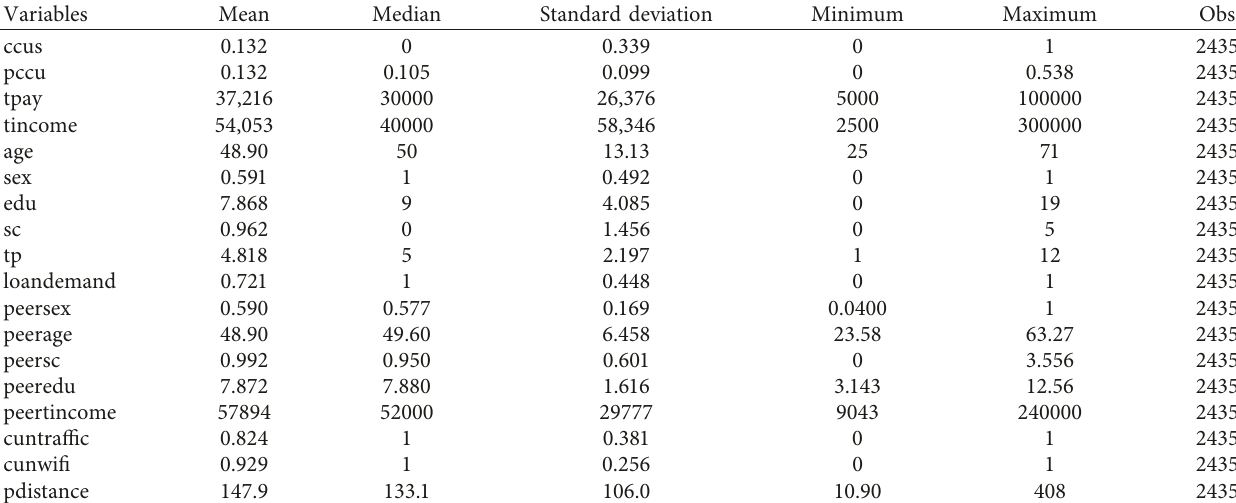
Table 2: Variable description.